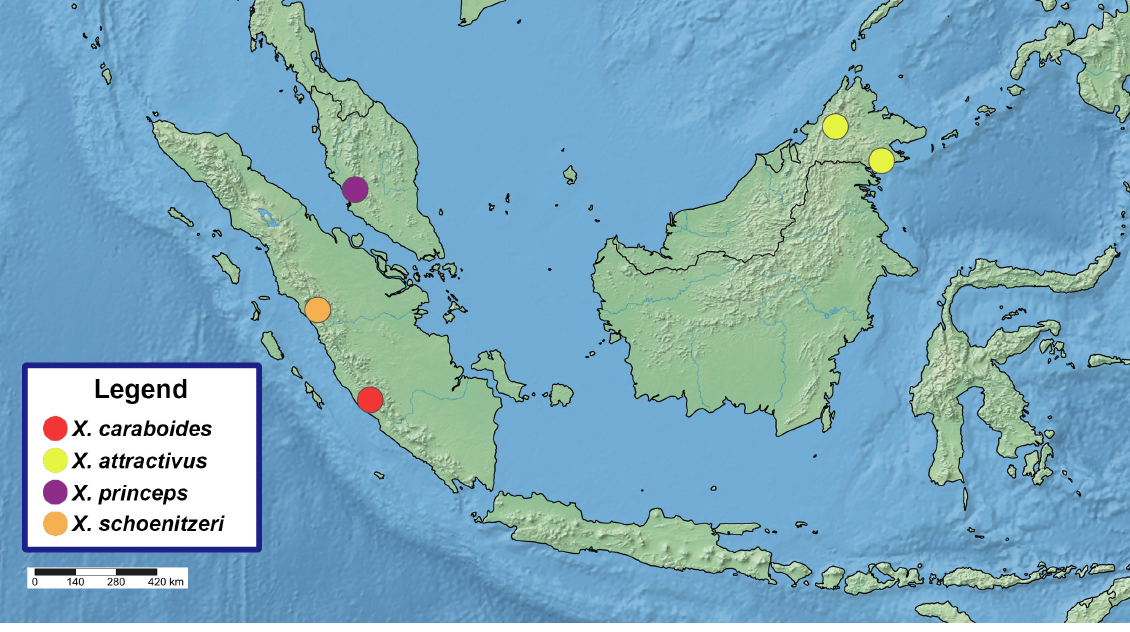
Fig. 60. Distribution of Xenorhyncocoris Miller,